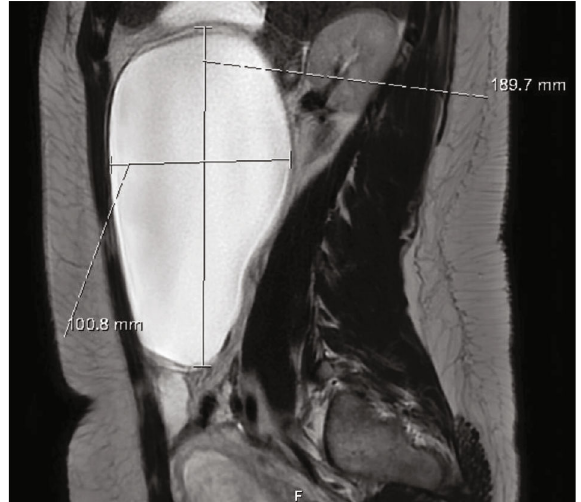
Figure 2: Sagittal view (MRI) of the right adnexal cyst. Note its simple appearance.